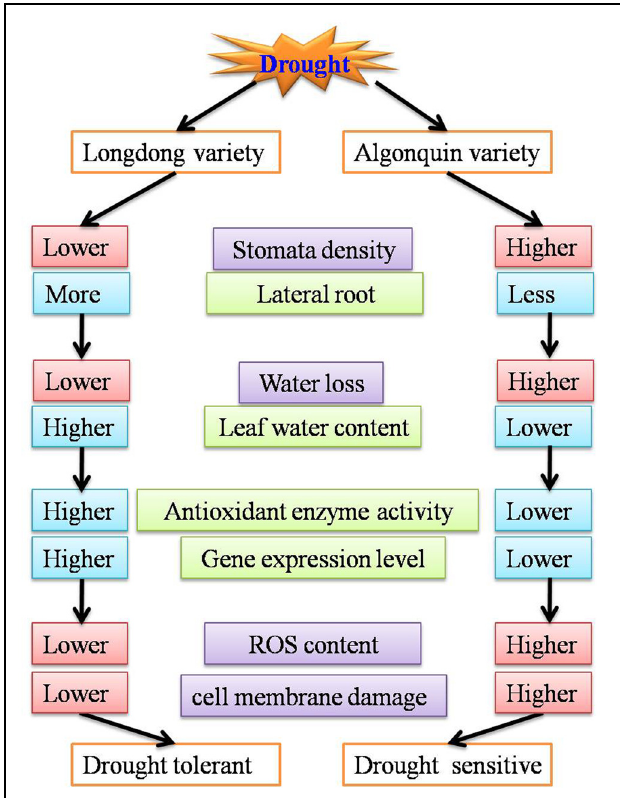
FIGURE 10 | A model depicting drought tolerance of two contrasting alfalfa